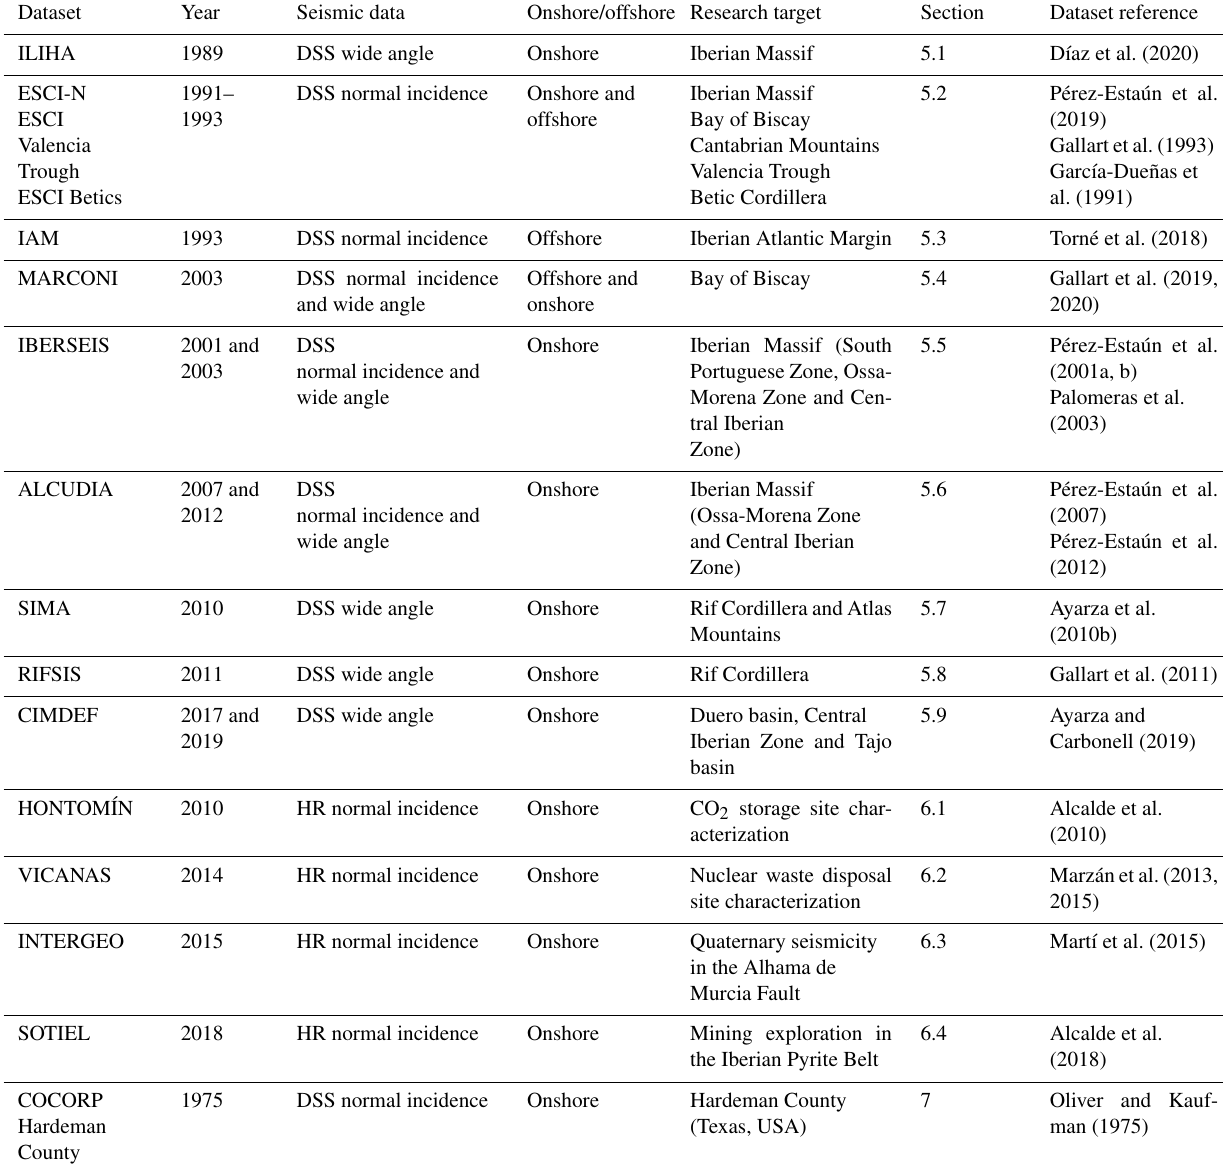
Table 1. Seismic datasets comprised in SeisDARE (DSS: deep seismic sounding; HR: high resolution). The location of the seismic datasets is shown in Fig. 3. Note that ESCI, MARCONI, IBERSEIS, ALCUDIA, and VICANAS comprise two or three datasets (see text for details).